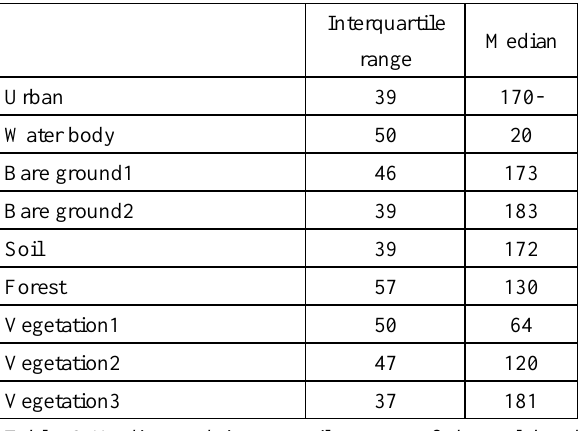
Table 2 Median and interquartile range of thermal band